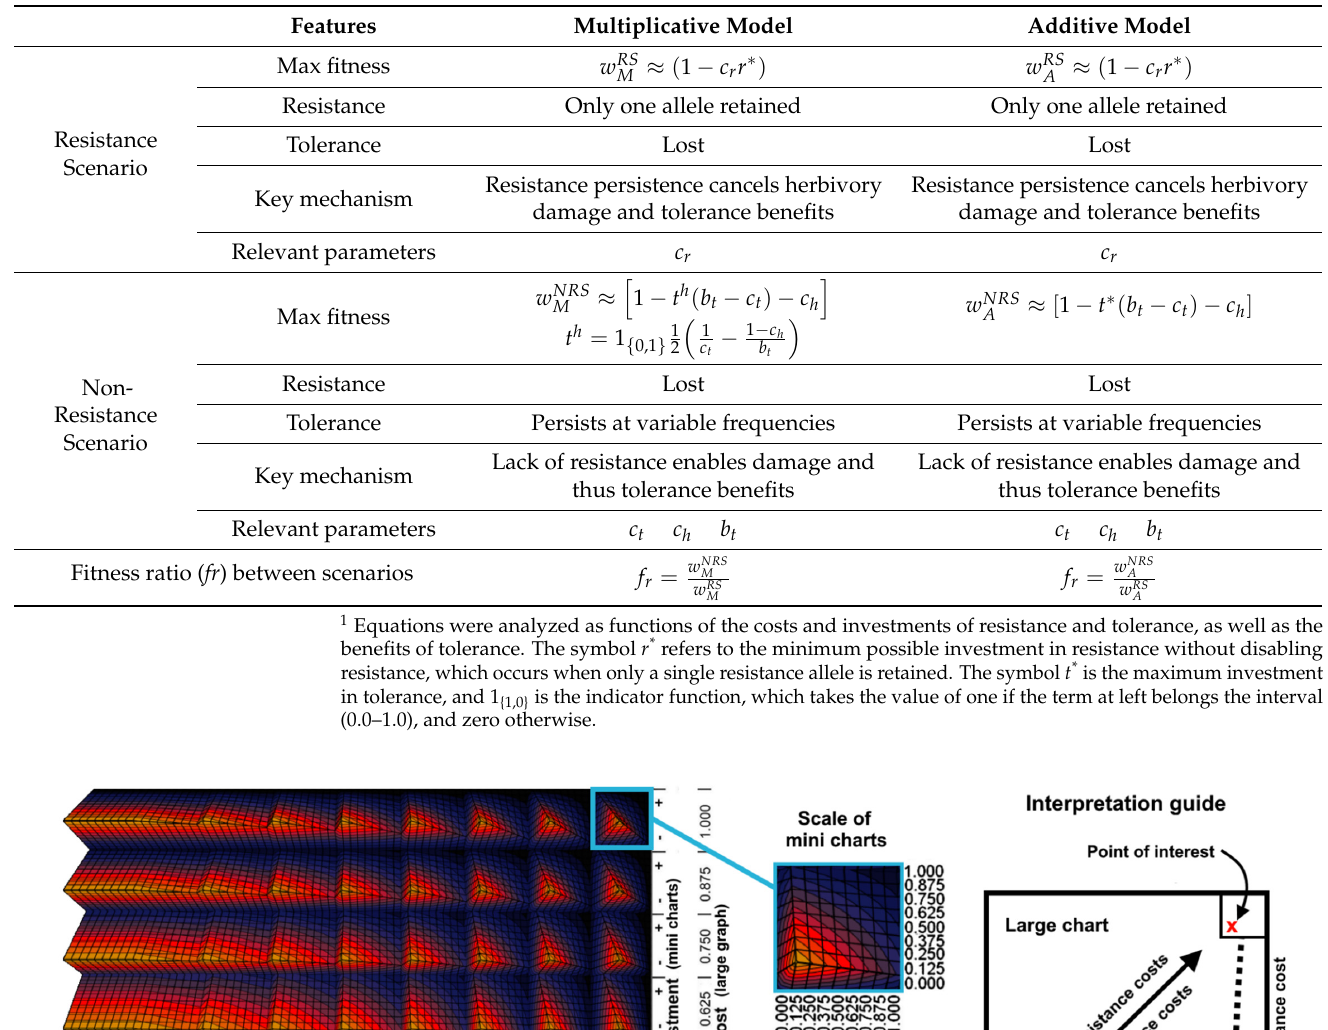
Table 1. Theoretical predictions obtained from Equations (1) and (2) 1 .